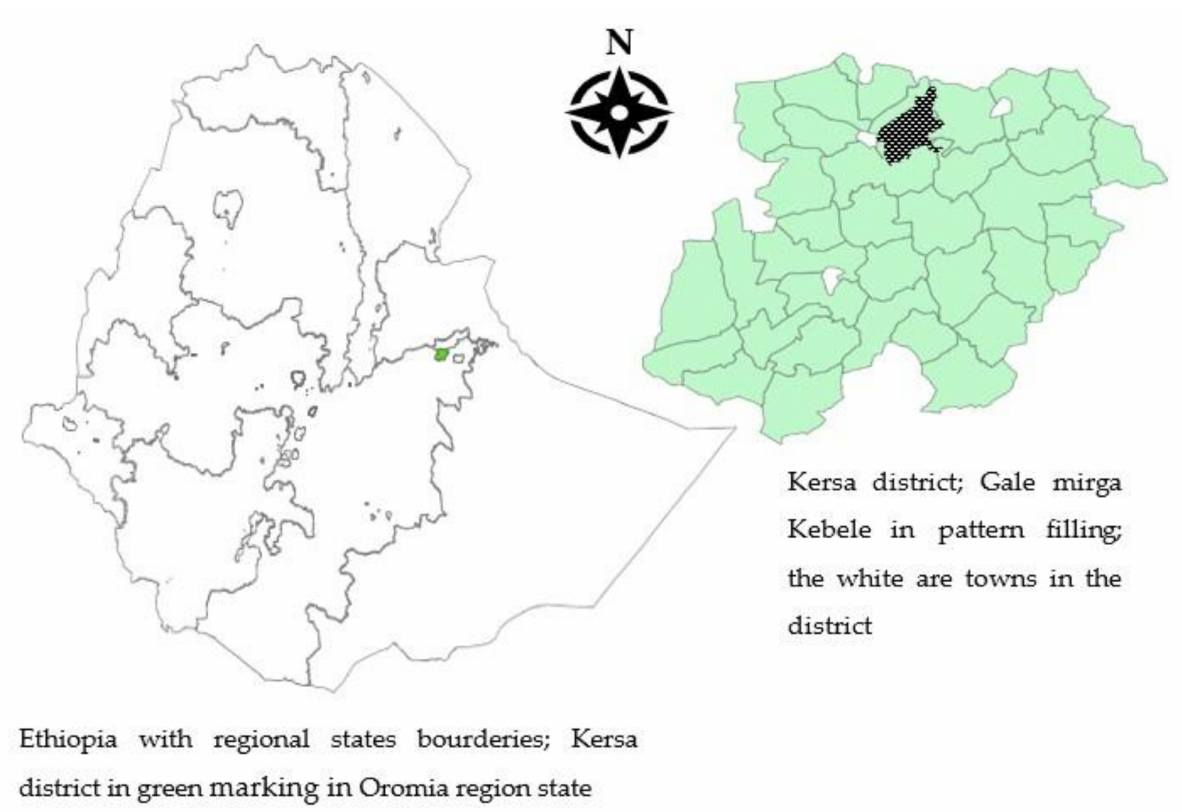
Figure 1. The map of the study settings of Gale Mirga kebele, Kersa district, eastern